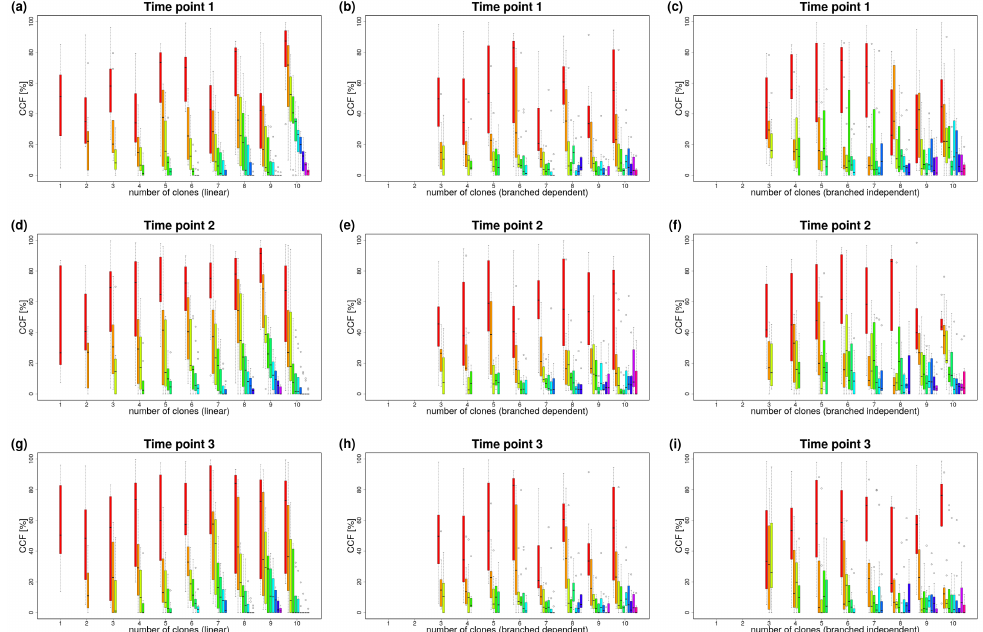
Figure A8. Boxplots showing the average CCF per cluster considering different numbers of clones at ( a ) time point 1, linear evolution, ( b ) time point 1, branched dependent evolution, ( c ) time point 1, branched independent evolution, ( d ) time point 2, linear evolution, ( e ) time point 2, branched dependent evolution, ( f ) time point 2, branched independent evolution, ( g ) time point 3, lin- ear evolution, ( h ) time point 3, branched dependent evolution, and ( i ) time point 3, branched independent